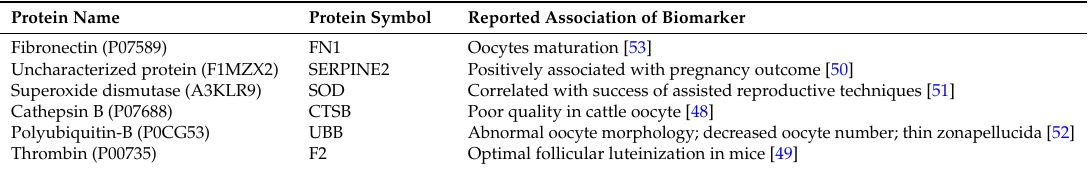
Table 5. The biomarkers identified from